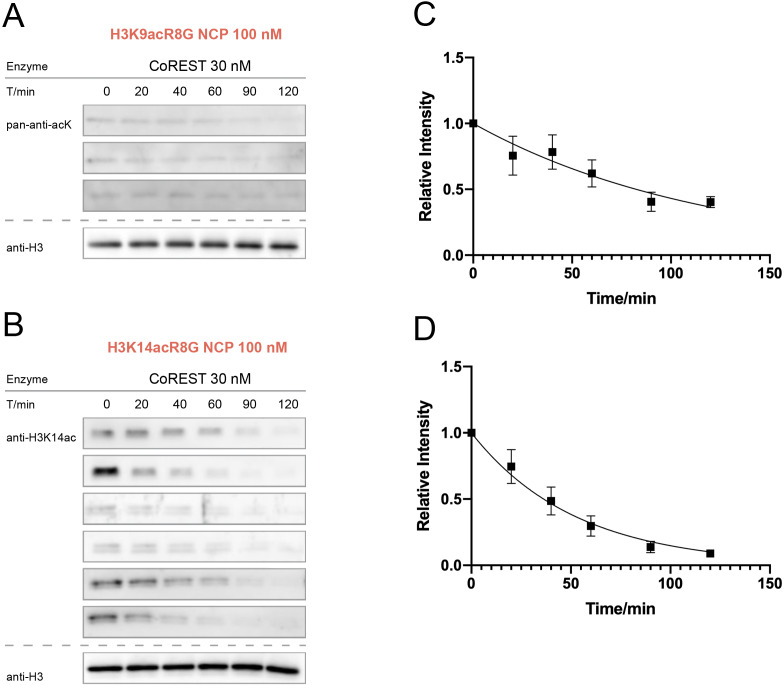
CoREST activity assay over nucleosomes with H3K9acR8G or H3K14acG13R.(A) H3K9acR8G (n = 3 for nucleosome assay), (B) H3K14acG13R (n = 6 for nucleosome assay). (C) Curve fitting for H3K9acR8G nucleosome kinetics with 30 nM CoREST, and (D) Curve fitting for H3K14acG13R nucleosome kinetics with 30 nM CoREST.